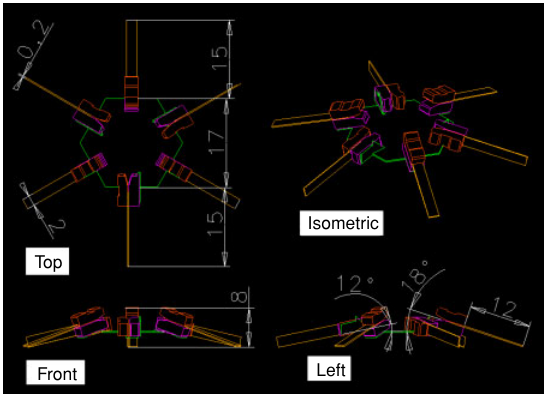
Figure 11 Dimensions of Walker-2.